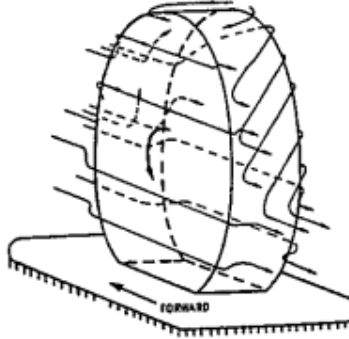
Figure 1. Tyre airflow schematic by Oswald and Browne